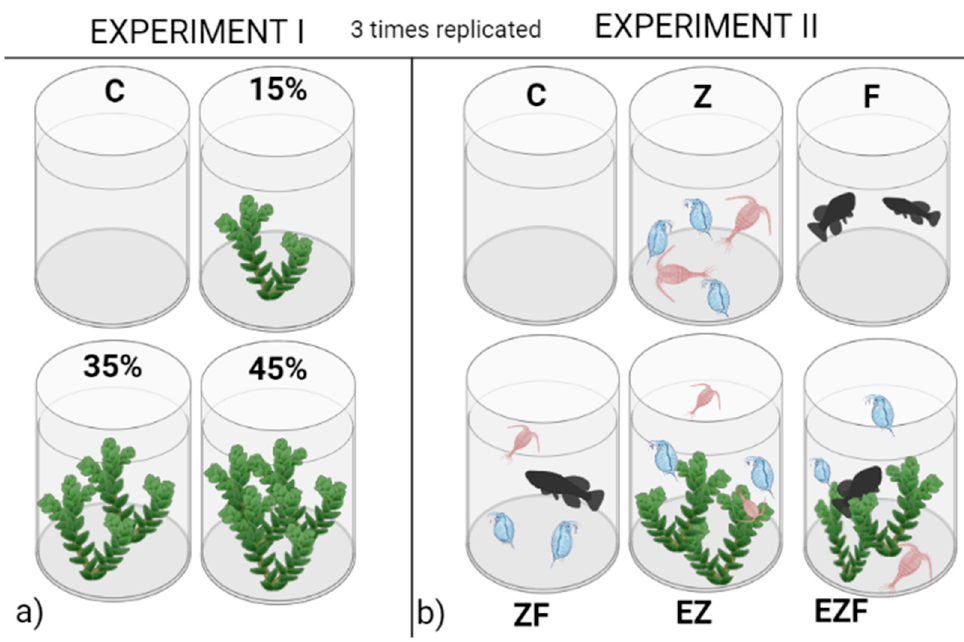
Figure 1. ( a ) Experiment I design. Each tank contained 100 L of water from Yahuarcocha Lake. The treatments contained different amounts of fresh Egeria densa as follows: “Control” (C), 15% with 2.5 gWWL − 1 (g of wet weight per liter) of Egeria densa , 35% with 4 gWWL − 1 , and 45% with 5 gWWL − 1 . Each treatment was replicated 3 times. ( b ) Experiment II design. Each tank contained 100 L of water from Yahuarcocha Lake. Six experimental units were established: “Control” (C); “Fish” (F); zooplankton (Z), a combination of zooplankton and fish (ZF); a combination of Egeria densa (35% with 4 gWWL − 1 ) and zooplankton (EZ); and a combination of Egeria densa , fish, and zooplankton (EFZ). Table 1. Experimental setup. Experiment I: 4 treatments of C (control) and 15%, 35%, and 45% PVI of Egeria densa compared with the initial values (I) of phytoplankton biomass, cyanobacteria density ( Planktothix ), size of Planktotrix, and nutrients for a duration of 10 days. Experiment II: 6 treatments compared with initial values of C, Z (zooplankton); F (fish); and the combinations of ZF, EZ (35% PVI of E. densa and zooplankton), and EZF for a duration of 12 days.